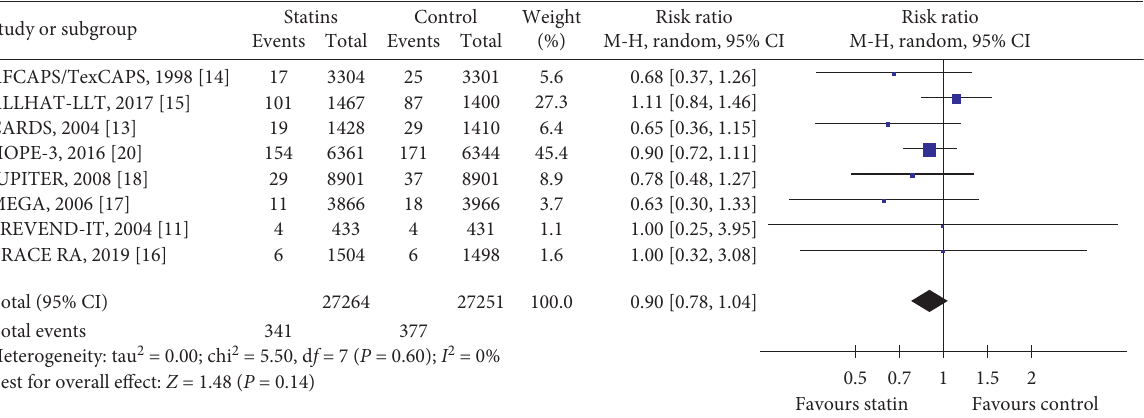
Figure 5: The occurrence of cardiovascular mortality in the included